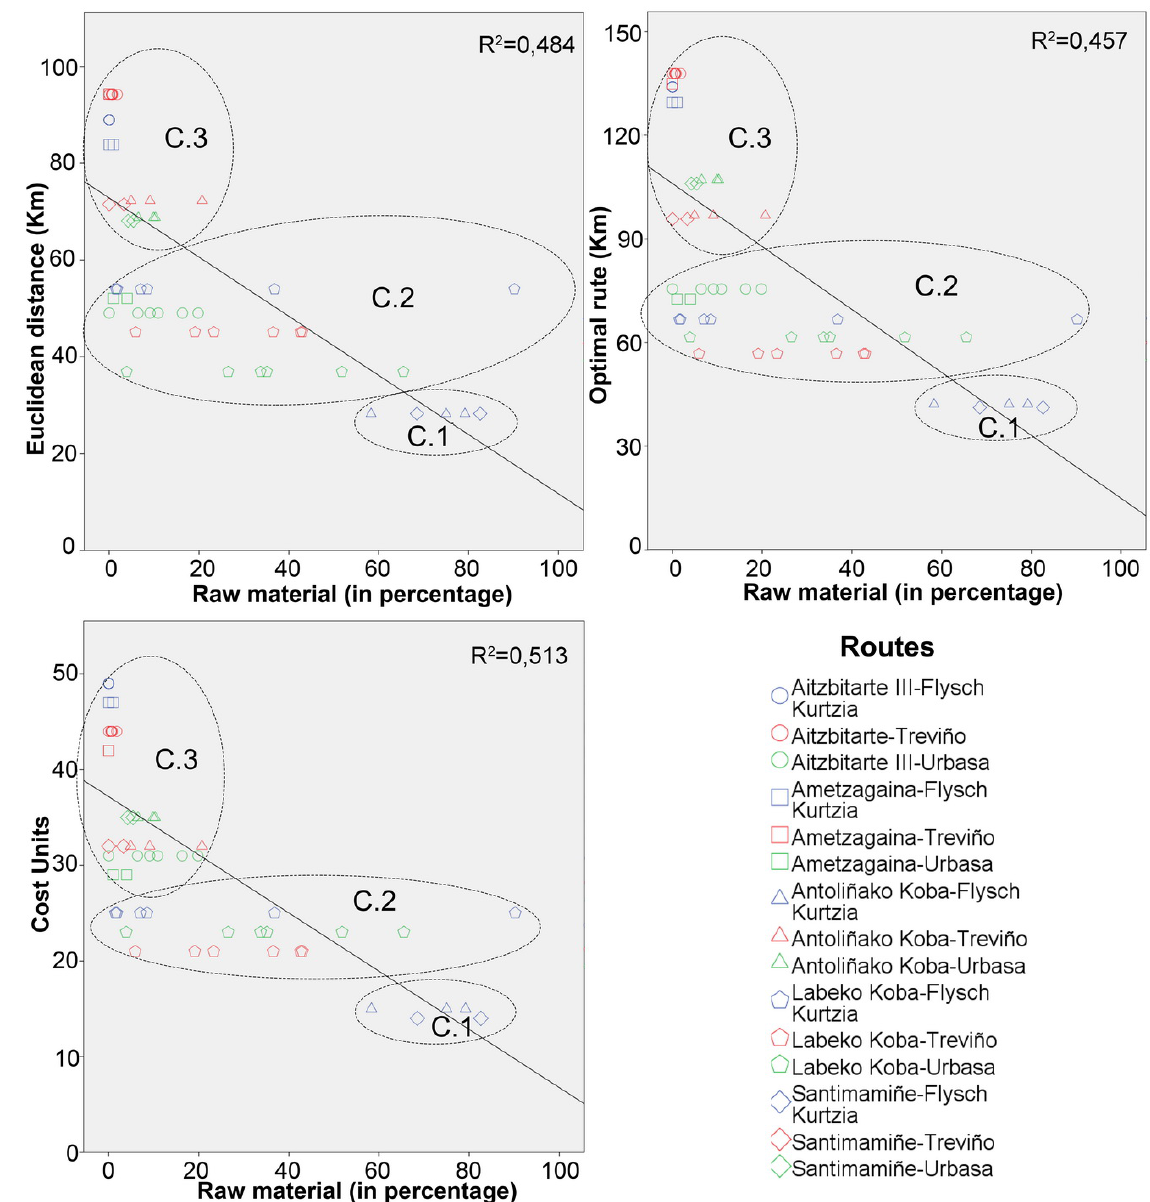
Figure 8. Triple biplot chart with the three clusters proposed for each type of measurement. Each chart shows the percentage of raw material on the horizontal axis and the value of the measurement of each methodological proposal on the vertical axis. The two first are expressed in Km and the last one in Cost Units. It must be noted the points which compose each cluster are different depending on the measurement applied. Abbreviations: C.1 - Cluster 1; C.2 - Cluster 2; C.3 - Cluster